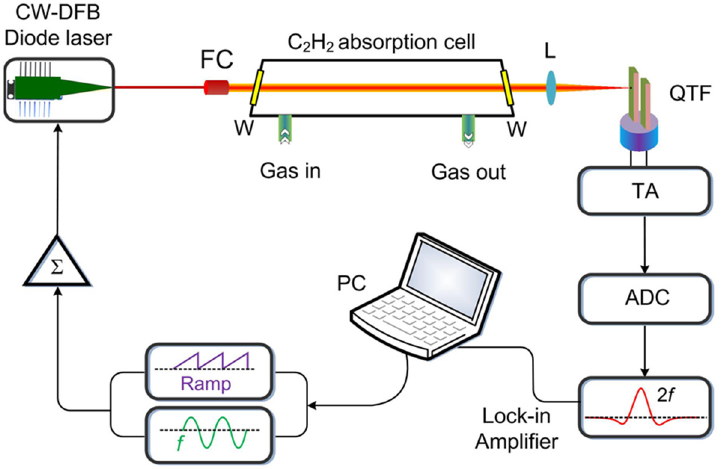
Figure 2. Experimental setup of the LITES sensor system. CW-DFB diode laser: continuous wave, dis- tributed feedback diode laser; FC: fiber collimator; W: CaF 2 window; L: CaF 2 plano-convex lens; TA: transimpedance amplifier; ADC: analog-to-digital converter. Reproduced with permission from Ref.